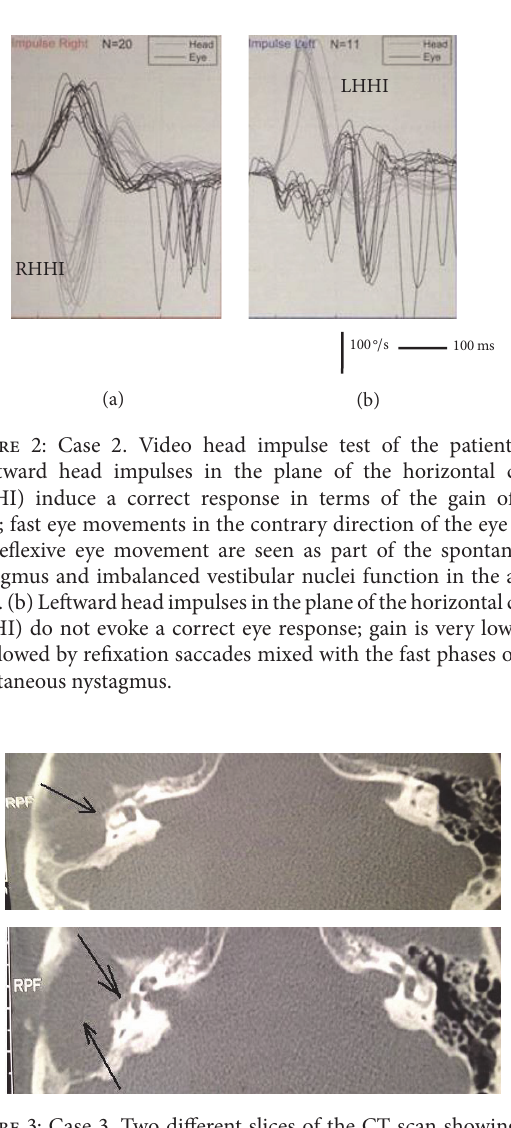
Figure 3: Case 3 . Two different slices of the CT scan showing the fistula of the right horizontal semicircular canal and the middle ear filled with cholesteatoma and inflammatory